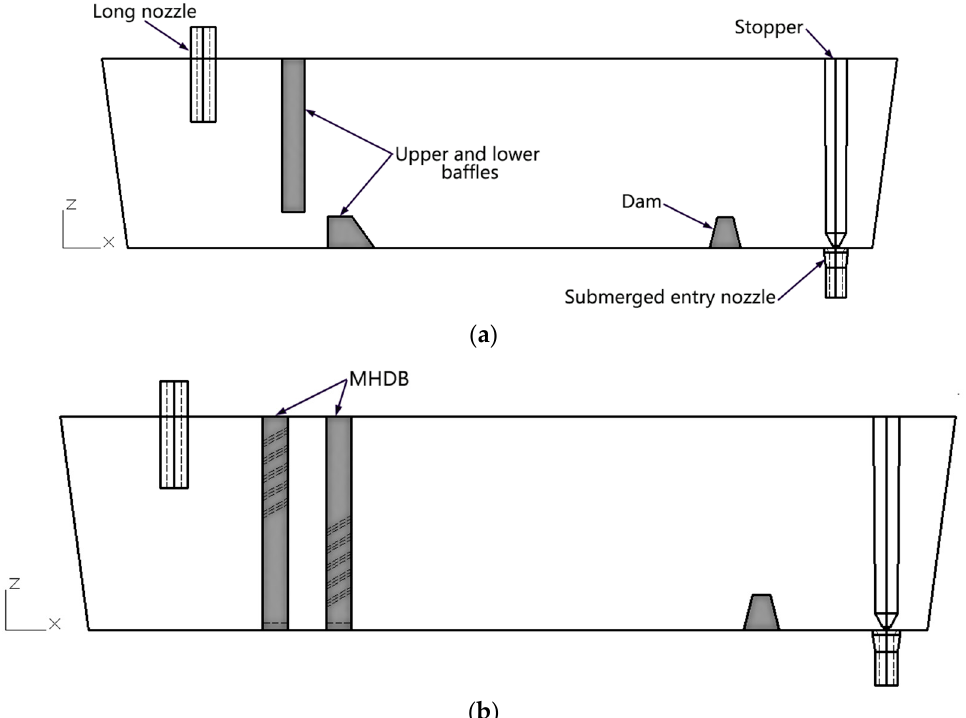
Figure 2. Original tundish and tundish with MHDB. ( a ) Original tundish; ( b ) Tundish with MHDB. Table 1. MHDB and tundish dimensions and parameters.